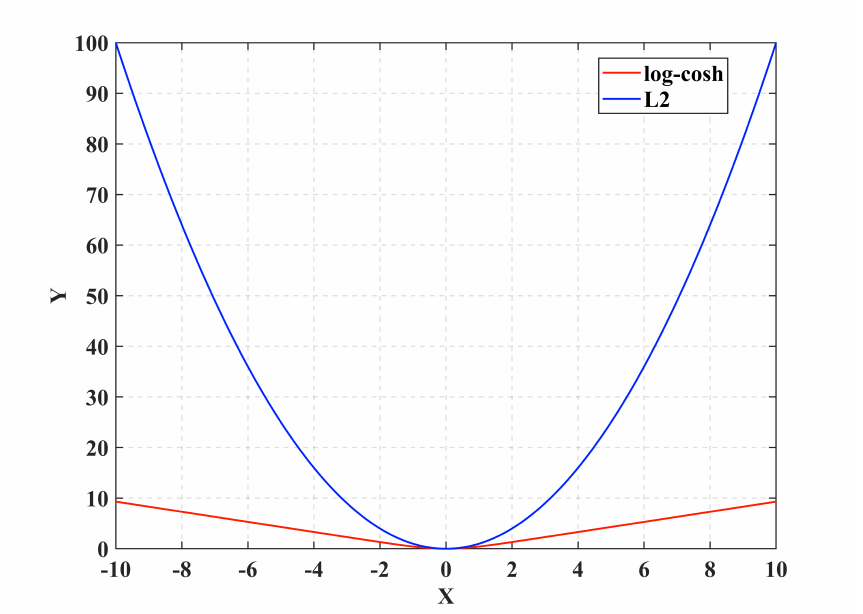
Figure 4. Images of log − cosh and L 2